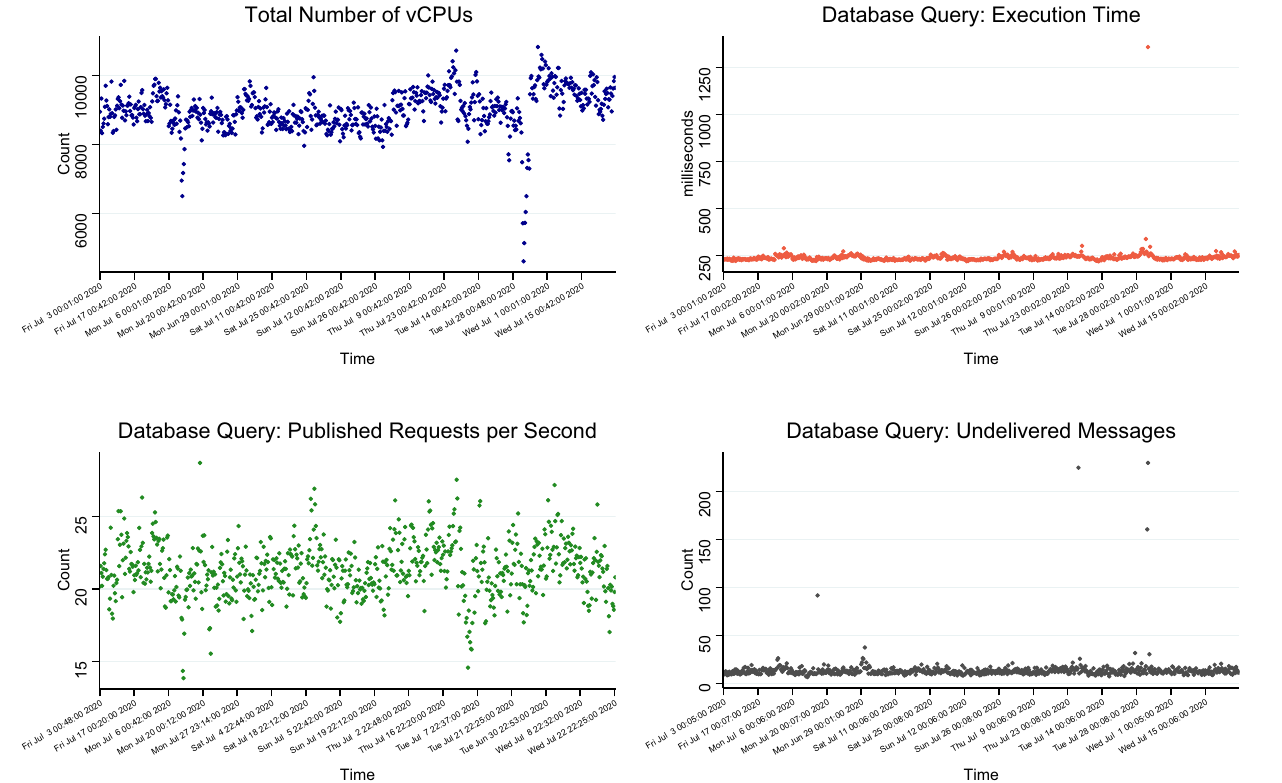
Figure 4. Performance of the Trellis model of processing human genomes, including GATK variant calling and quality assessment, at the speed of 600 genomes a day. The data presented came from processing 100,000 genomes in the Million Veteran Program. ( Top left ) Total number of vCPUs used. These included all vCPUs used by Trellis, including for variant calling and QC, as well as for running the database and Jupyter analysis notebook. ( Top right ) Execution times for database query functions. They remained constant at about 200 ms/ query . This demonstrated that queries were well optimized and the database remained performant as load fluctuated. ( Bottom left ) Number of messages published to the database query function per second. At the peak times, about 20 database queries messages were sent out per second, reading the maximum capacity that the current architecture of Trellis was able to handle. ( Bottom right ). Number of undelivered messages. Rarely were more than 20 messages